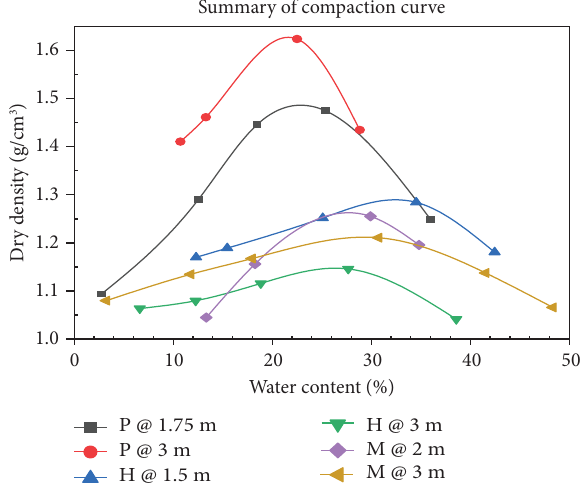
Figure 6: Summary of the compaction test